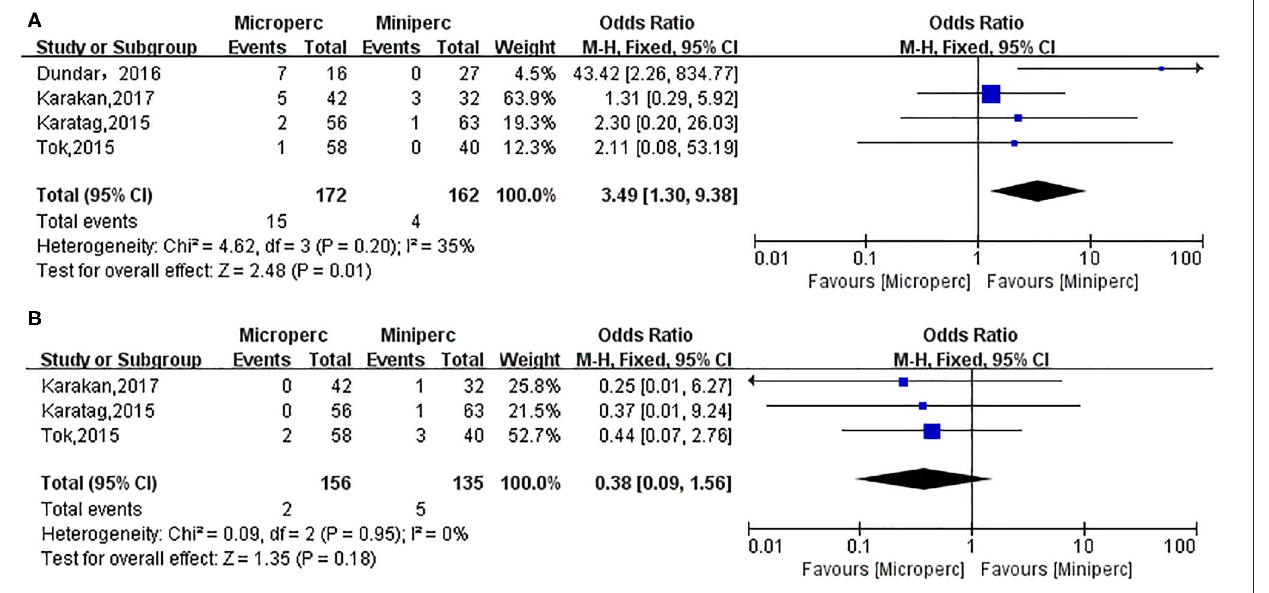
FIGURE 6 | Forest plot for renal colic requiring D-J stent insertion (A) and urinary tract infection (B)